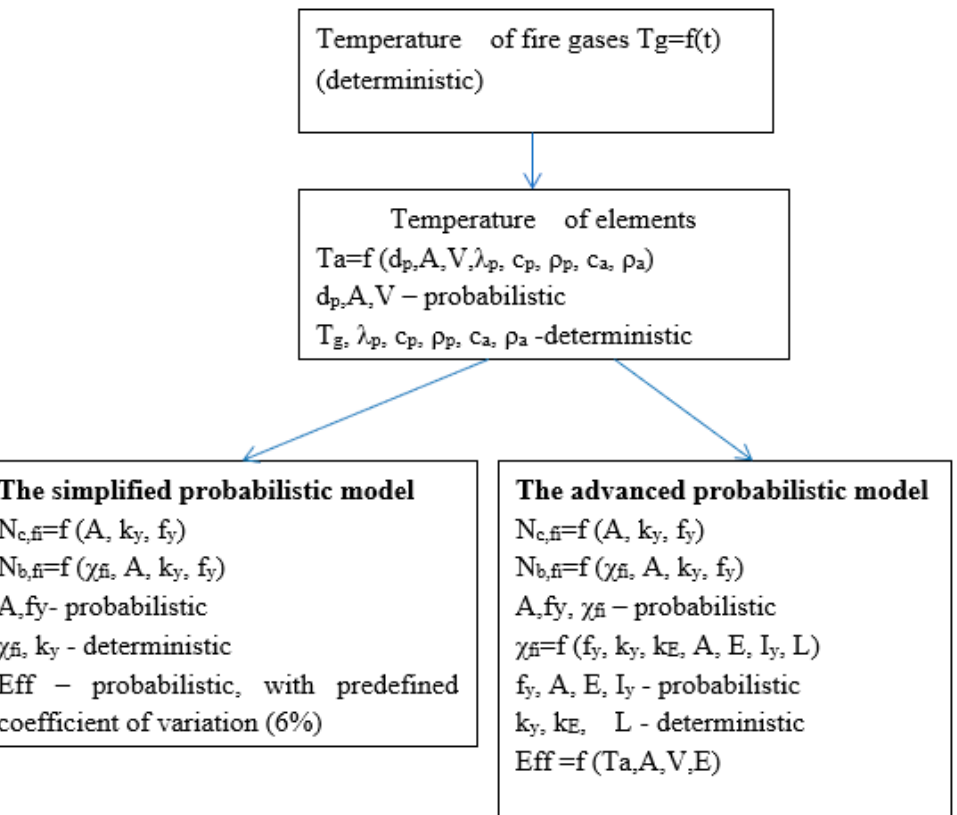
Figure 3. The algorithm of computation.{ \ displaystyle \ Theta = 2 \ pi U_{2}. \ ,}.